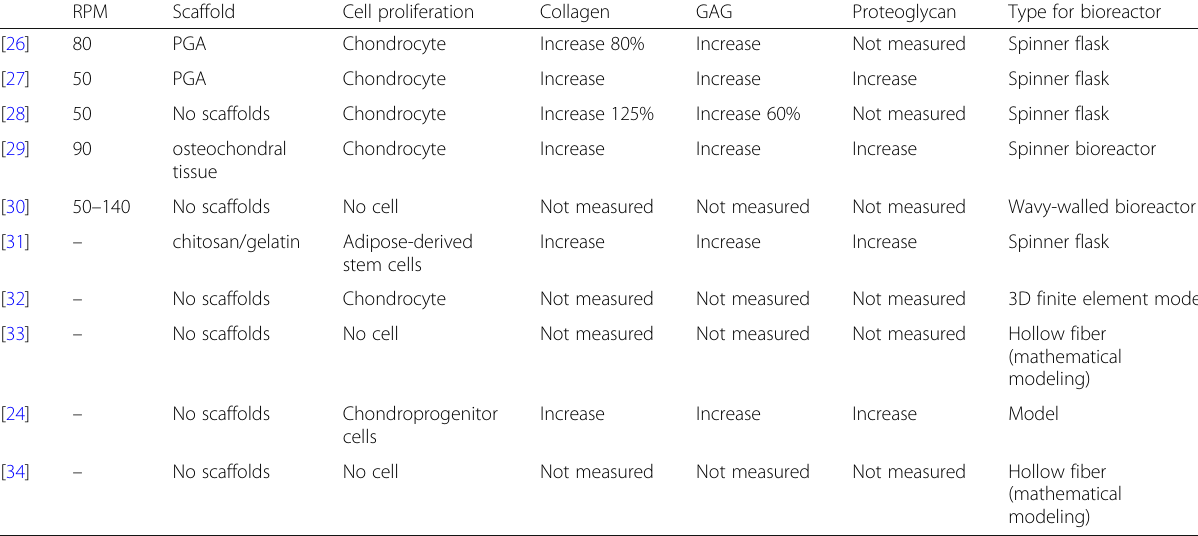
Table 6 Experimental fluid shear by different bioreactor and scaffolds and effects on chondrocyte proliferation and matrix composition RPM